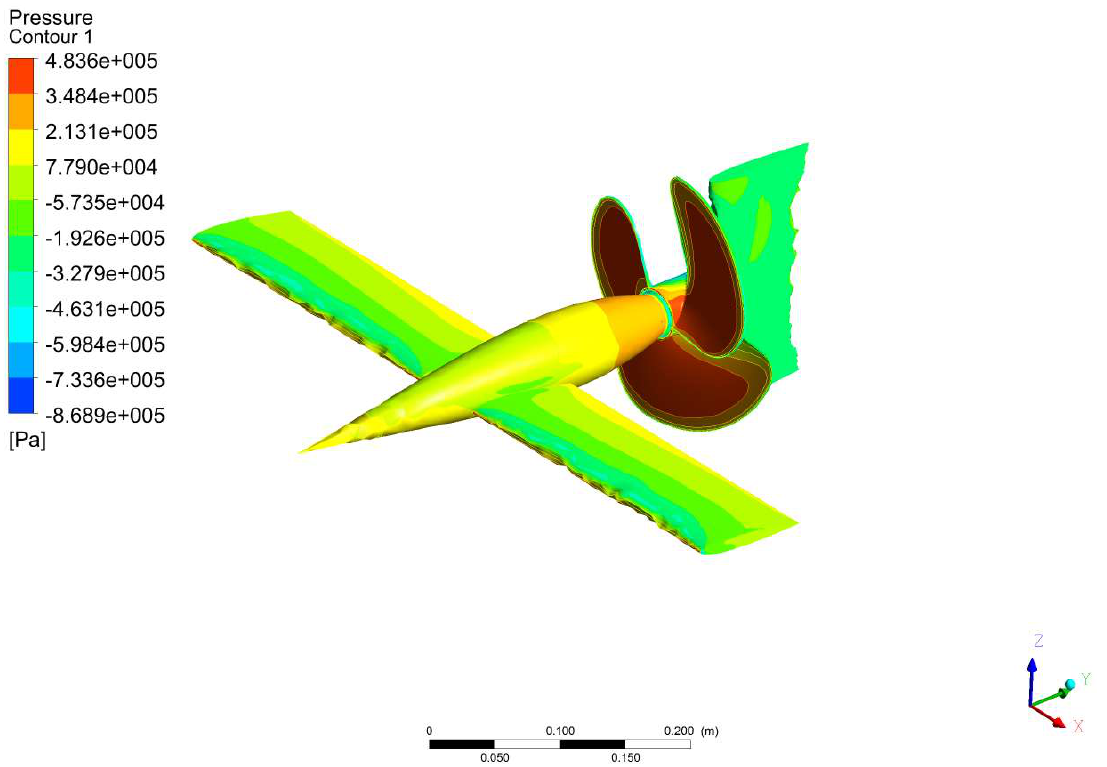
Figure 31. Variations of hydrodynamic pressure on US with rectangular wing.